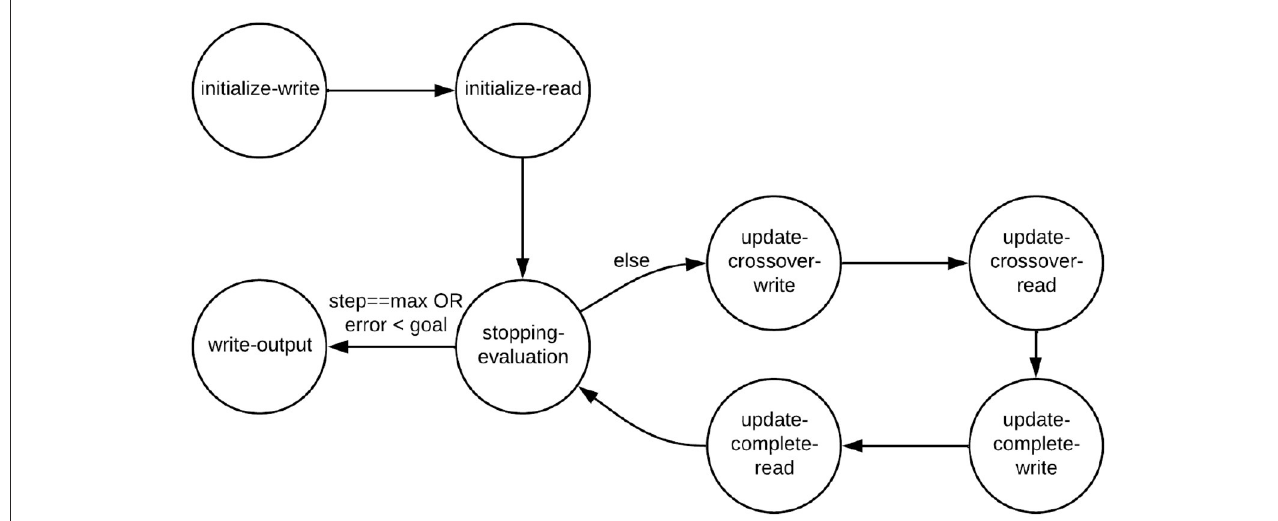
FIGURE3 Mode transition graph for the GA Core